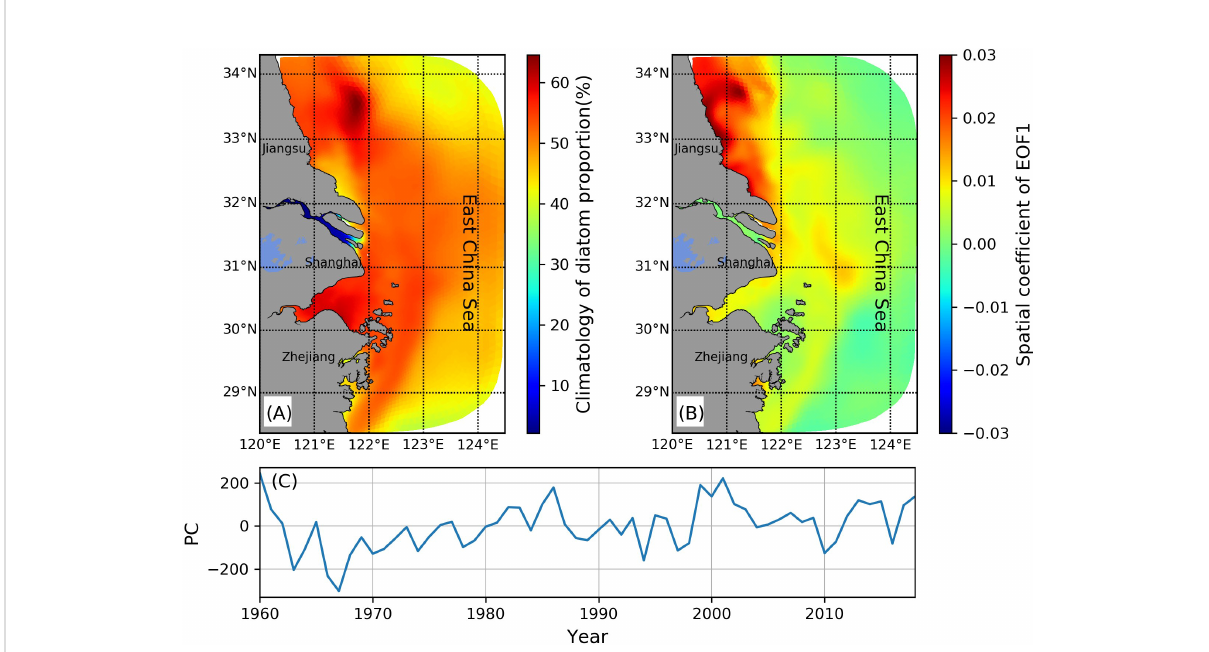
FIGURE 11 (A) Model simulated diatom proportion climatology calculated based on the model output from 1960 to 2018. (B) The spatial coef fi cient of the fi rst empirical orthogonal function (EOF) mode of diatom proportion. (C) The temporal amplitude of the fi rst EOF